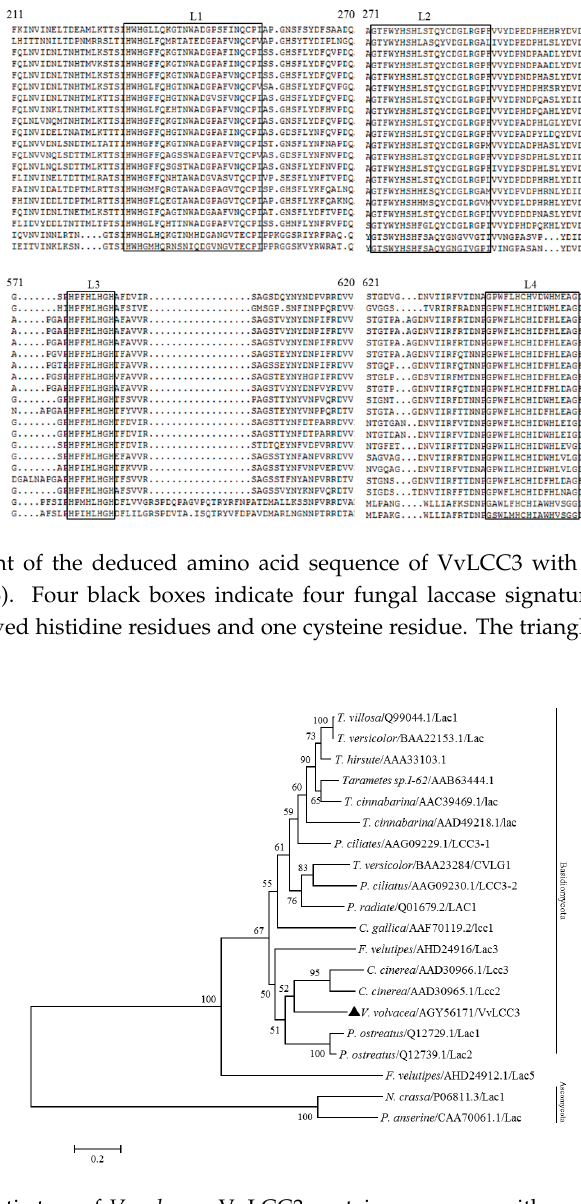
Figure 5. Phylogenetic tree of V. volvacea VvLCC3 protein sequences with amino acid sequences of